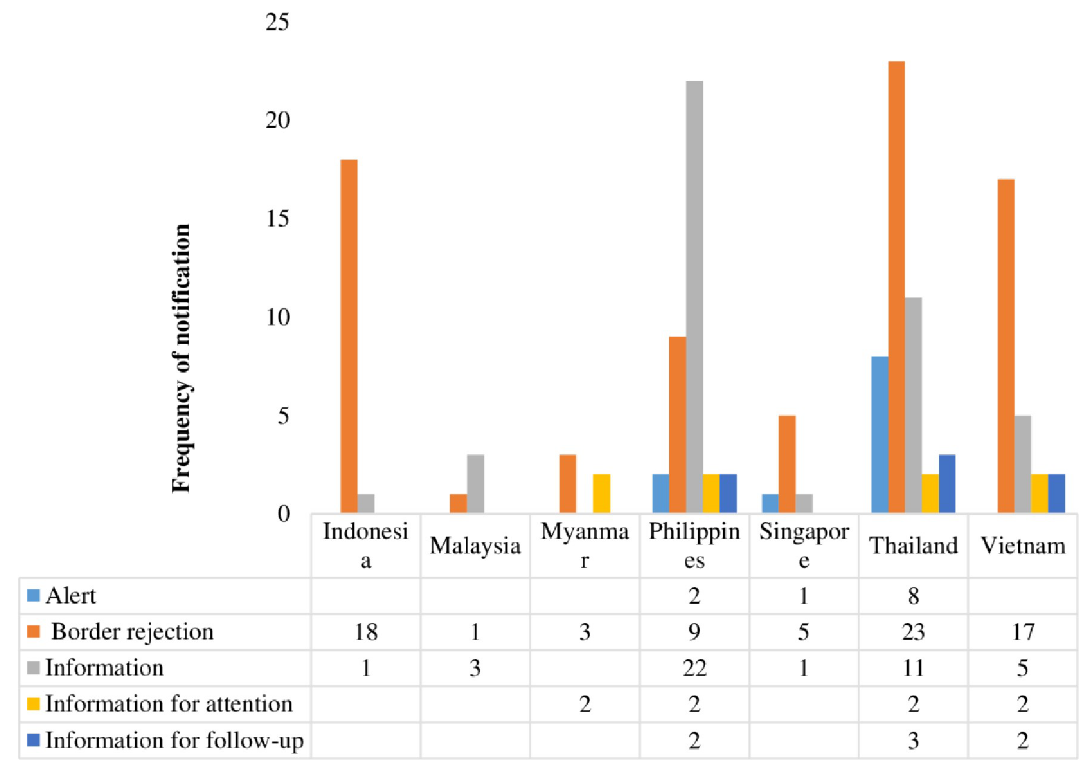
Fig 6. Notification types on food/feed exports from ASEAN (2000–2020).